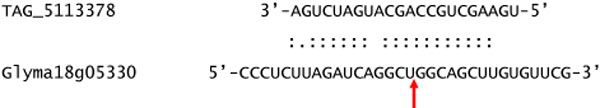
miRNA target gene cleavage site validated by 5"RACE. miRNA TAG_5113378 cleavage site on its target gene Glyma18g05330 as identified by 5' RACE is highlighted by red arrow. In the alignment ":" indicates a perfectly complementary base and "." indicates a G:U wobble.